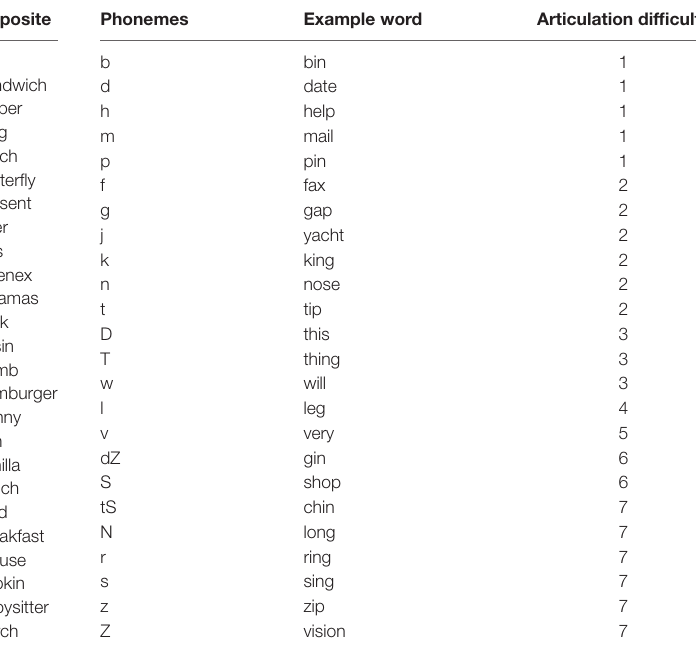
TaBle 2 | Difficulty of articulation measures for each consonant used in computing the difficulty of articulation of each word (given by the sum of the difficulty measures of all of the consonants in the